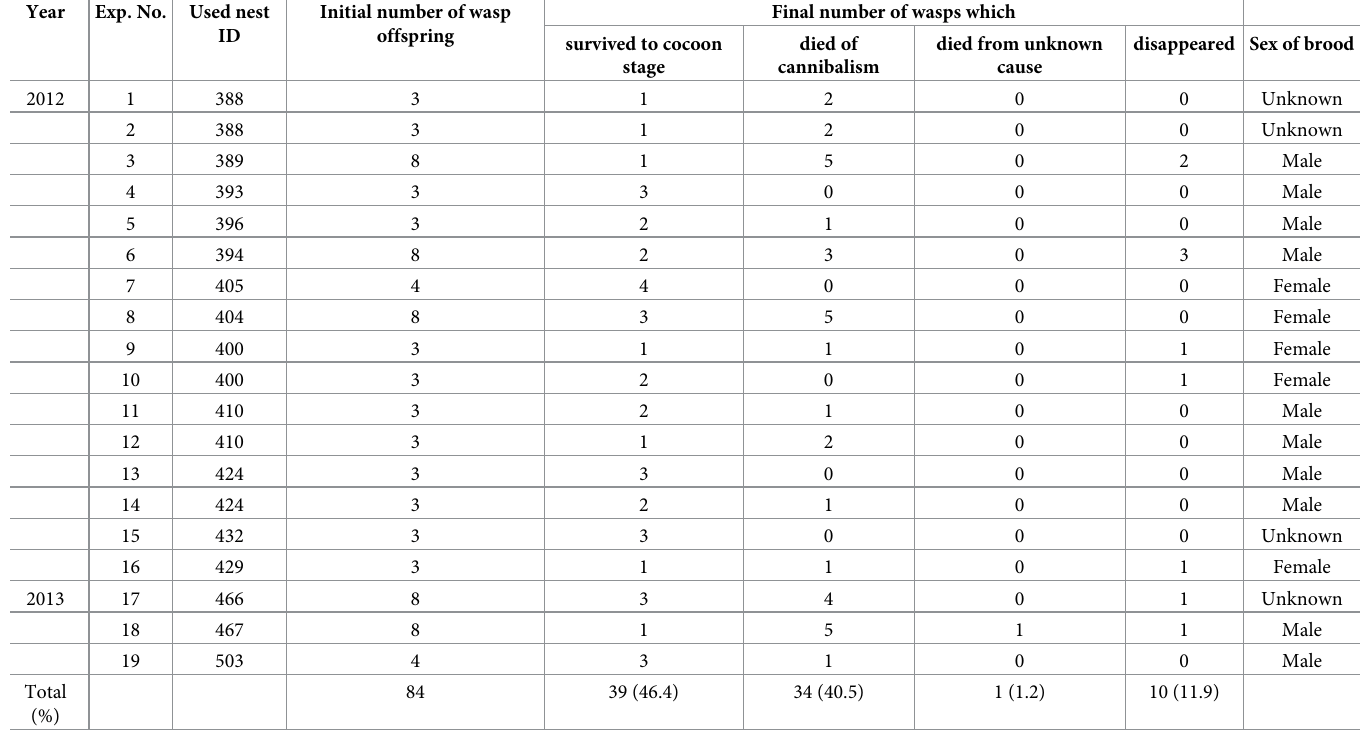
Table 1. Outcomes of individual broods in partial brood rearing experiments performed under frame-by-frame recording by digital camera. Year Exp. No. Used nest